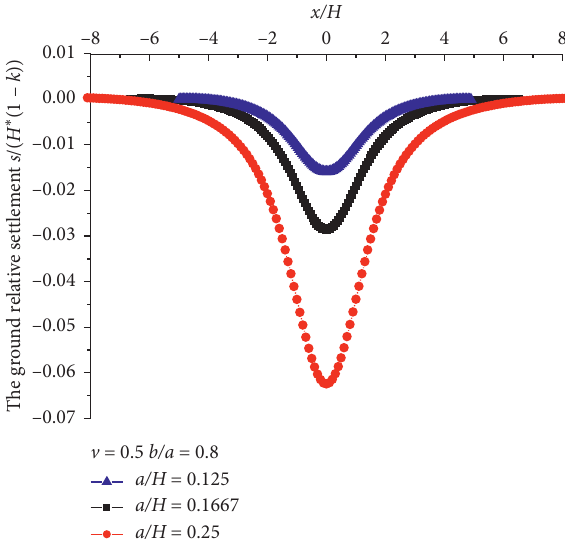
Figure 12: Vertical displacement of ground when a / H changes.